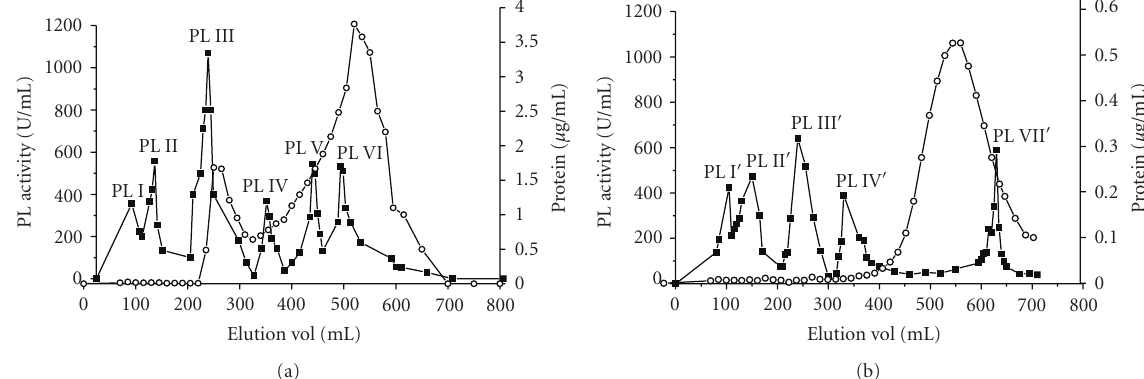
Figure 3: Elution of PL activity from Sephadex G75 chromatography columns (3 . 0 × 80 . 0 cm) previously equilibrated with 20 mM acetate bu ff er, pH 5.0. (a) PL from SSF; (b) PL from SmF. ( ) = Pl activity; ( ) =